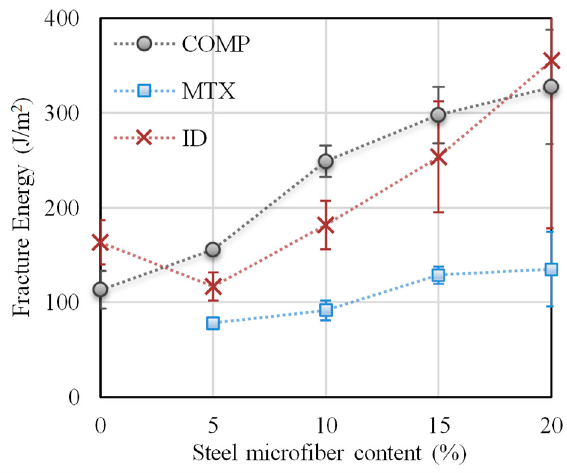
Figure 8. Fracture toughness of AAS mortar with different amounts of steel microfibers determined by: ( a ) Two different fracture models; ( b ) The effective crack model—contribution of plain AAS matrix.